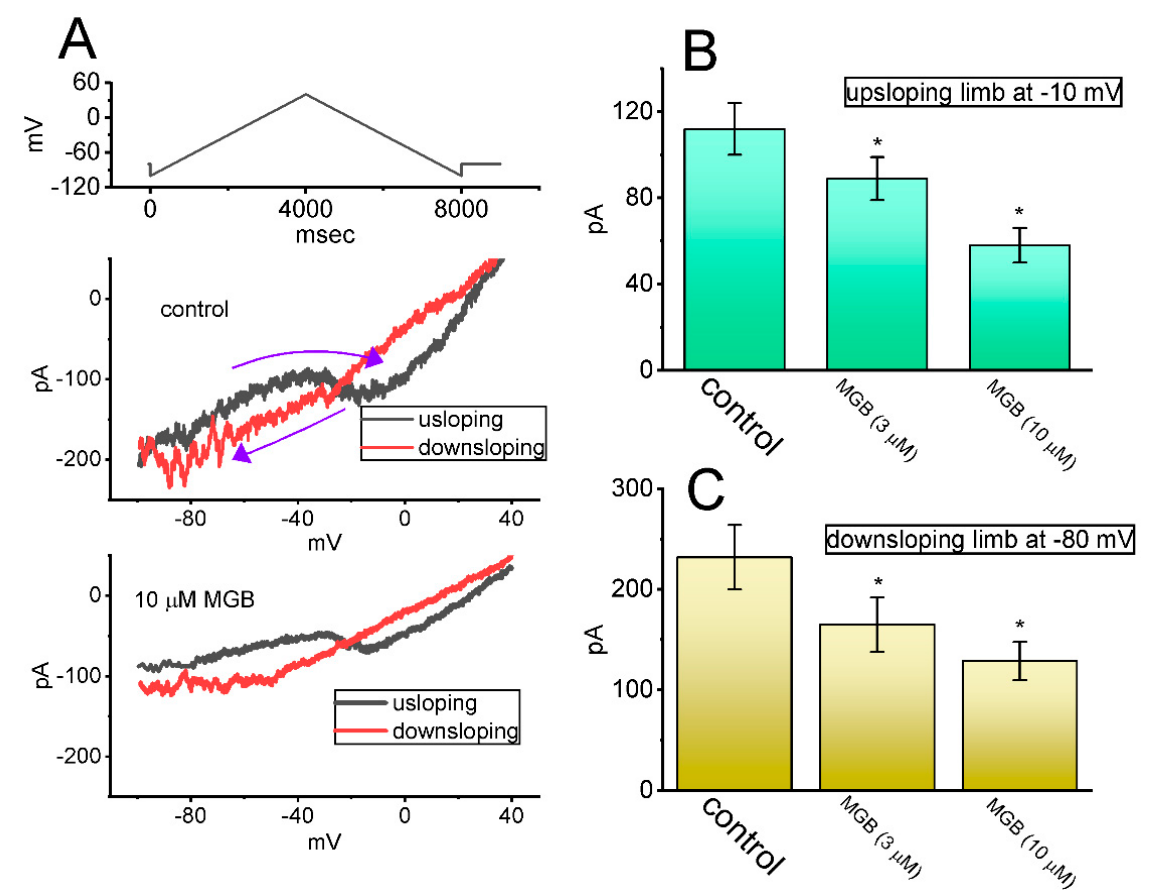
Figure 7. Effect of MGB on persistent I Na ( I Na(P) ) activated in response to upright isosceles triangular V ramp , which was utilized to mimic the depolarizing or repolarizing slopes of bursting patterns in electrically excitable cells. ( A ) Representative current traces activated by isosceles triangular V ramp for a duration of 8 s, or with a ramp speed of ± 75 mV/s (indicated in the uppermost part). The black color in the upper and lower part of ( A ) indicates the current trace activated by the ascending limb of the V ramp , while the red color shows trace activated by the V ramp ’s descending limb. The uppermost part depicts the voltage protocol applied. The purple curved arrow indicates the direction of the current over which time goes during the activation of the triangular ramp pulse. Of note, there is a voltage-dependent hysteresis V hys (i.e., figure of eight configuration) of I Na(P) evoked by the isosceles triangular V ramp with or without the MGB (10 µ M) addition. In ( B , C ), summary bar graphs, respectively, show inhibitory effects of MGB (3 or 10 µ M) on the amplitude of I Na(P) activated by the upsloping (at − 10 mV) and downsloping (at − 80 mV) limb of the triangular V ramp (mean ± SEM; n = 7 for each bar). * This result is significantly different from controls ( p <